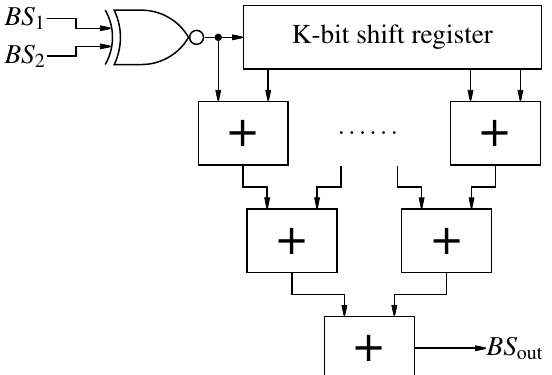
Figure 23. Modified multiplication of two bit-streams based on Delta Adder with simpler